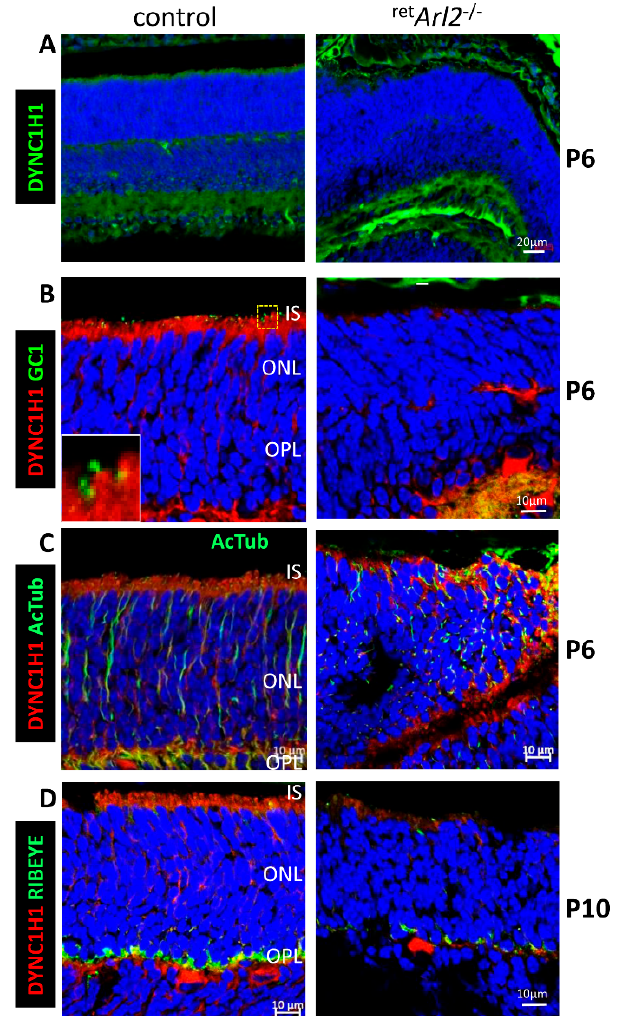
Figure 3. Immunohistochemistry with Arl2 cryosections. ( A – D ), ret Arl2 − / − (right panels) and control cryosections (left panels) were probed with anti-DYNC1H1 ( A – D ), anti-GC1 ( B ), anti-PSD95 ( C ), and anti-RIBEYE ( D ) antibodies as indicated. ( A – C ) are postnatal day P6 cryosections, D is P10. Note distorted ONL, poorly developed OPL and suppression of DYNC1H1 fluorescence.